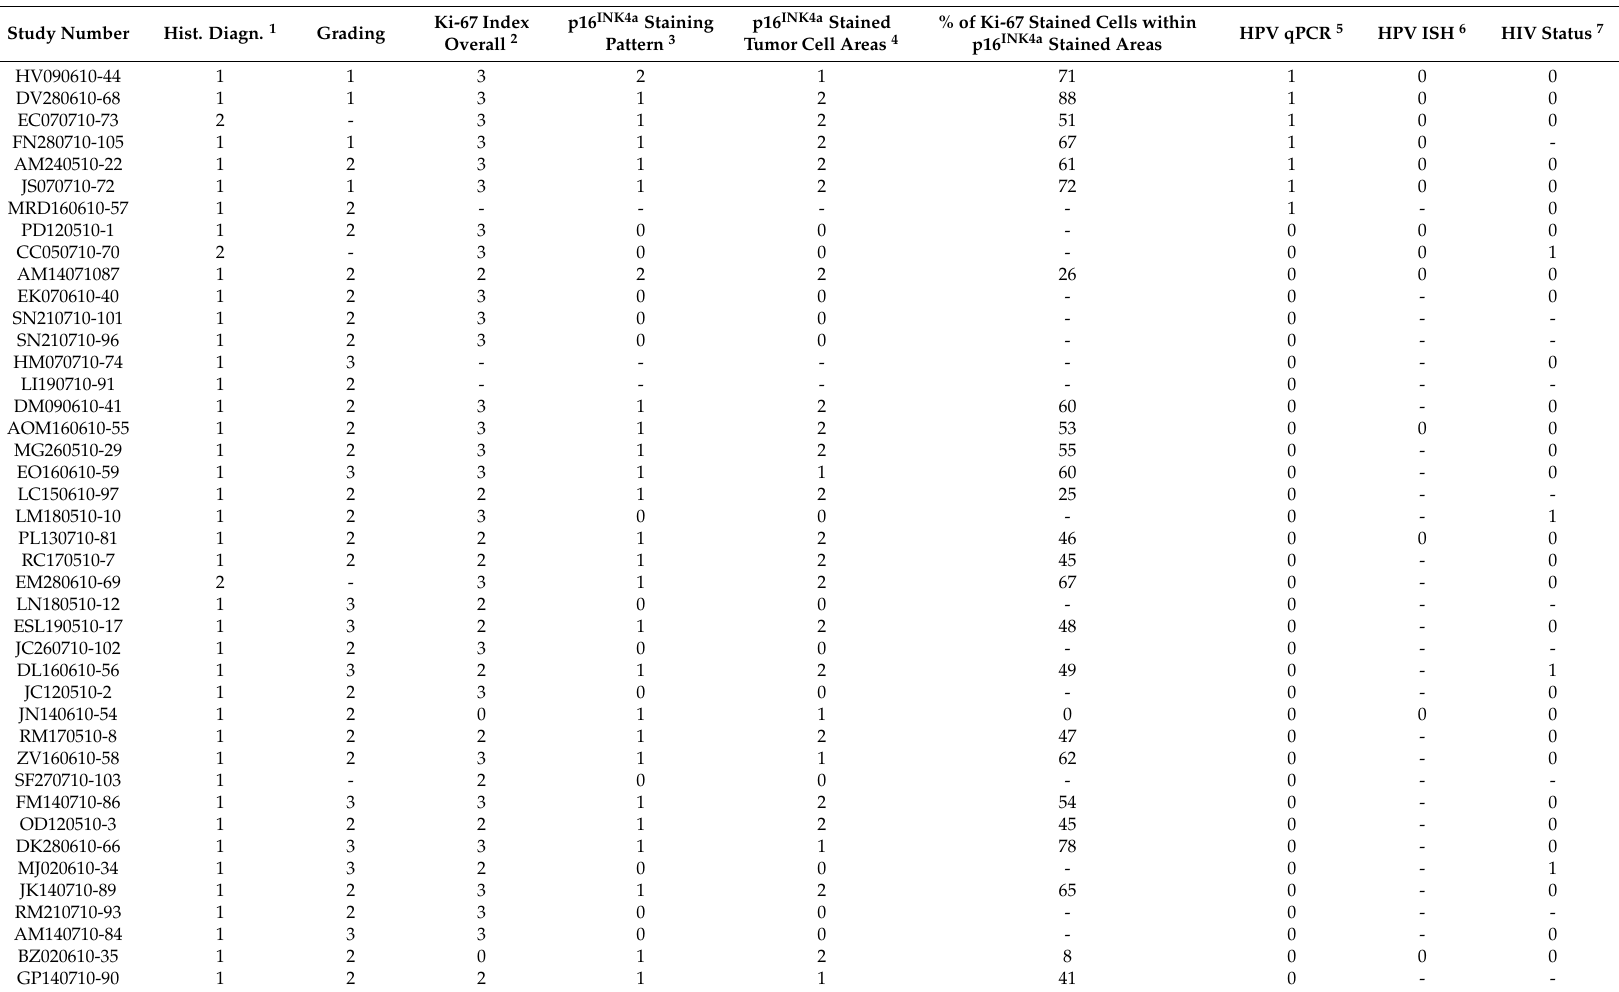
Table 1. Human papillomavirus (HPV), human immunodeficiency virus (HIV), p16, and Ki-67 status in esophageal squamous cell carcinoma (ESCC), dysplasia and histopathologically normal